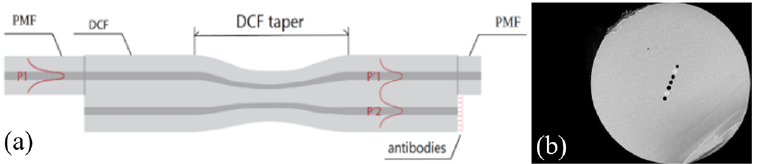
Figure 8. ( a ) Schematic diagram of tapered DCF structure and ( b ) SEM image of DCF. Reprinted with permission from [114].